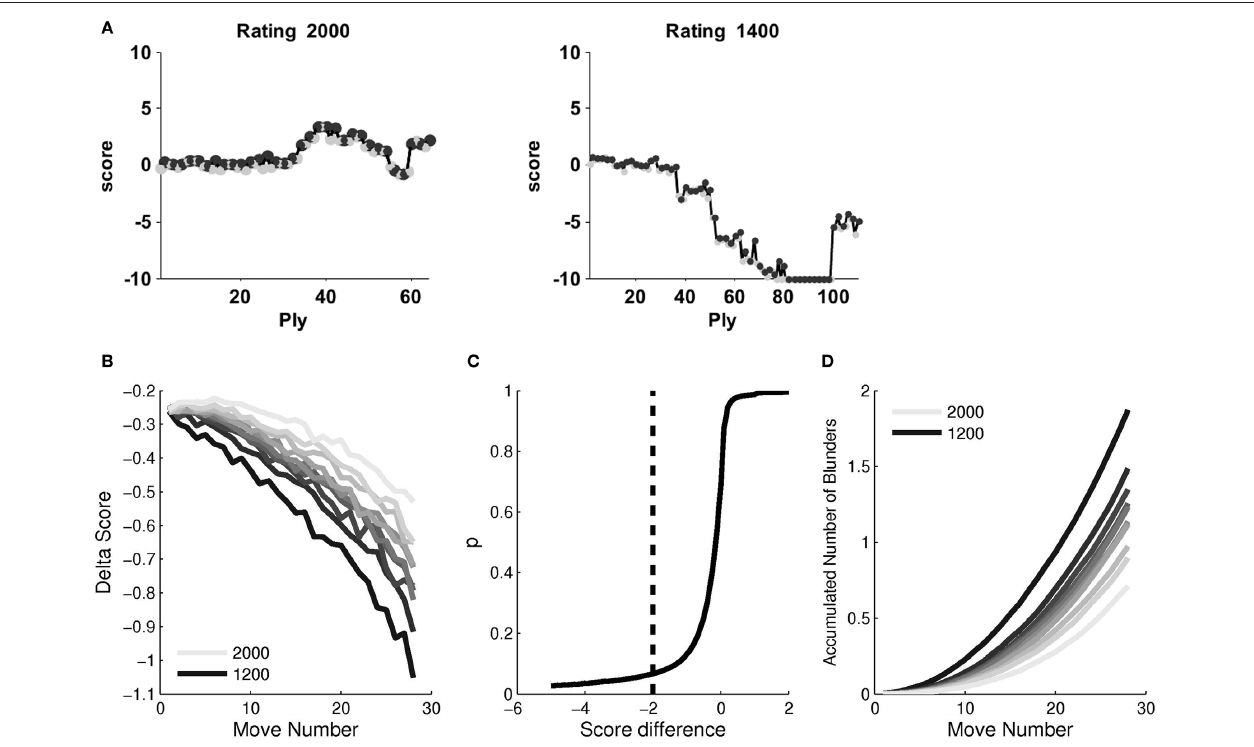
Figure 4 | Fluctuations in the value function of the position: (A) example of the evolution of the evaluation function for high rated (left) and low rated (right) player. (B) 〈∆ S 〉 as a function of move number. In each curve, players were rated according to their ratings (in 100 bins). Darker lines